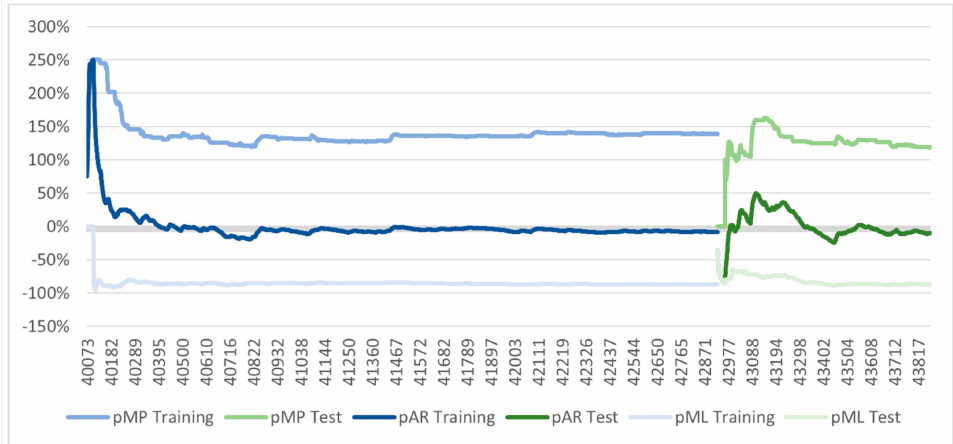
Figure 2. pMP, pML and pAR indicators over time for the training and test sets.